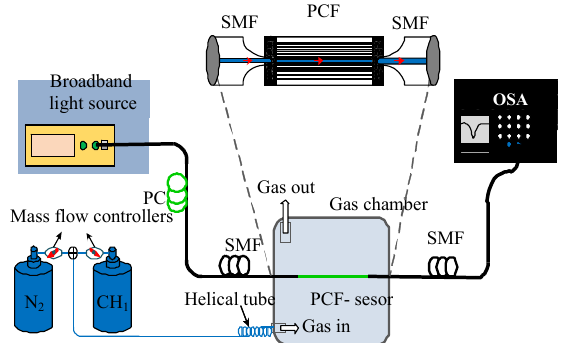
Fig. 7 Principle diagram of the experimental